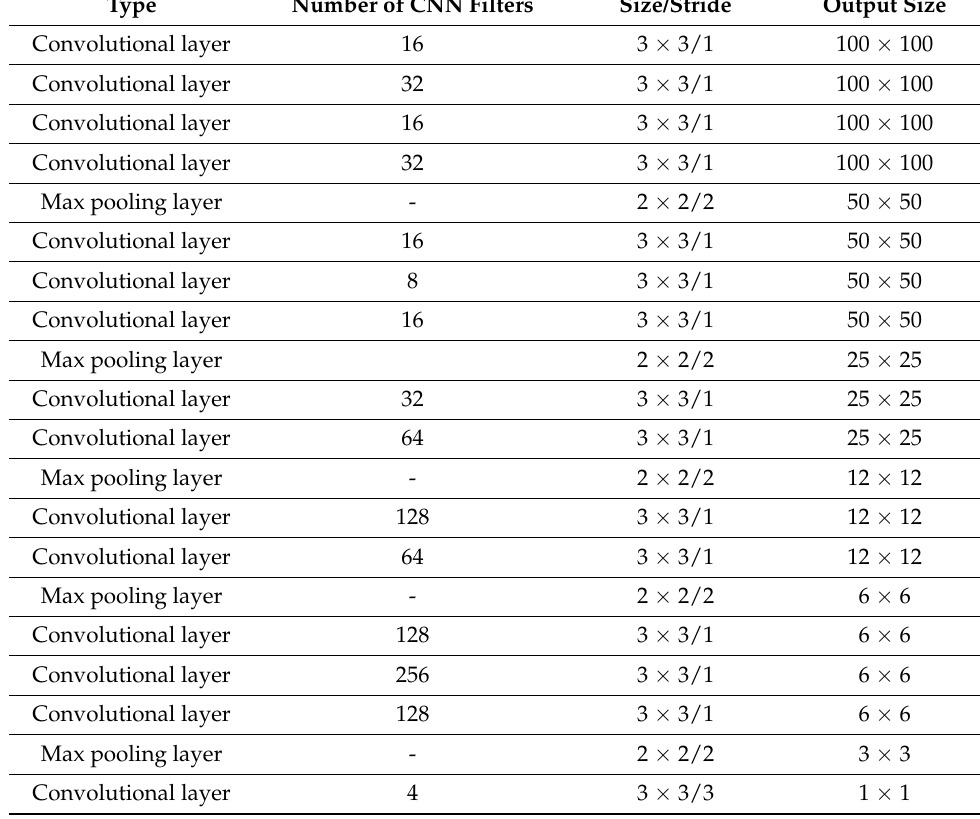
Table 1. Structure of